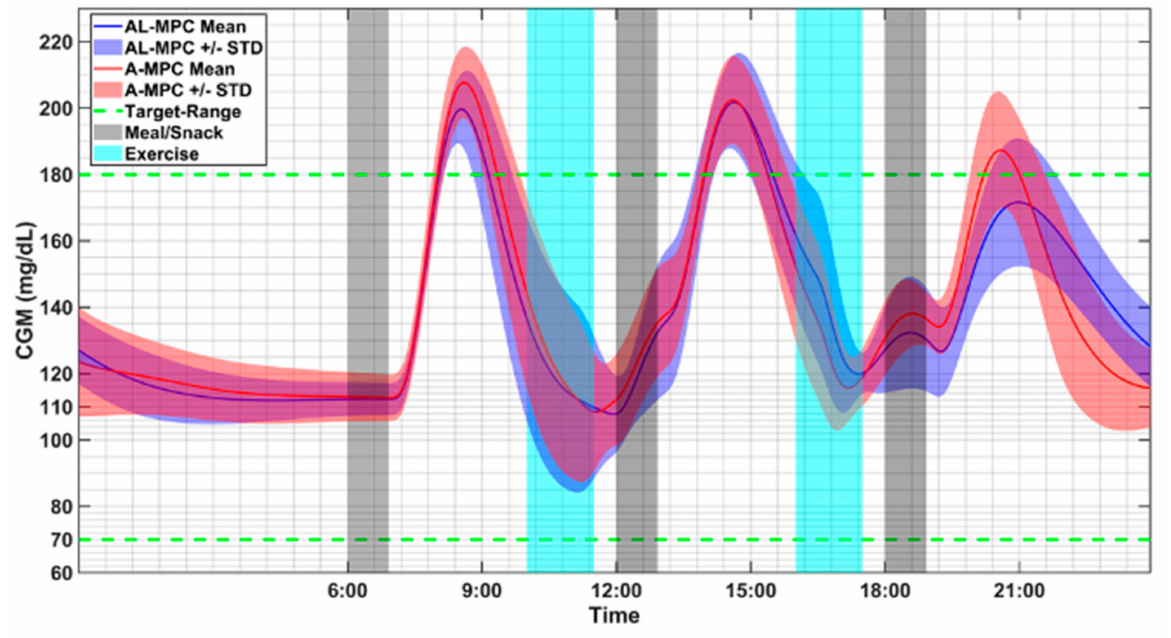
Figure 10. Closed-loop results of mAID for all subjects on day 30 [19].